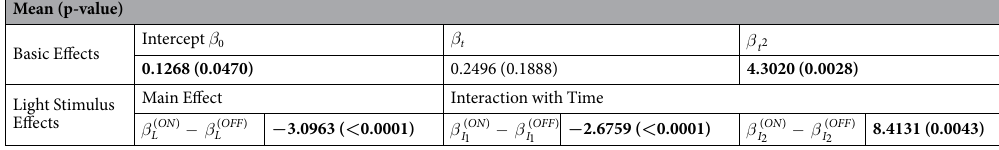
Table 3. The GLMM results of VMR data from 1 to 30s for AB larvae at 6